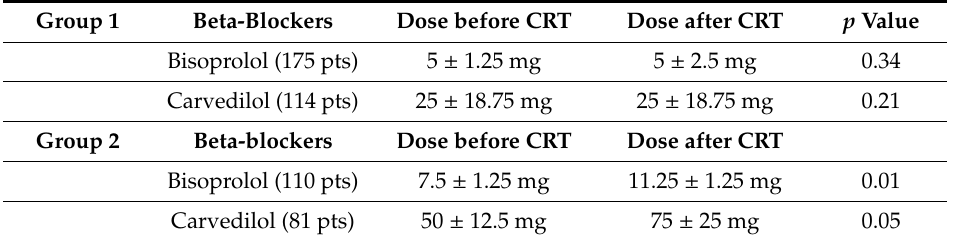
Table 4. β -blockers doses of the two study groups before and after cardiac resynchronization therapy. Group